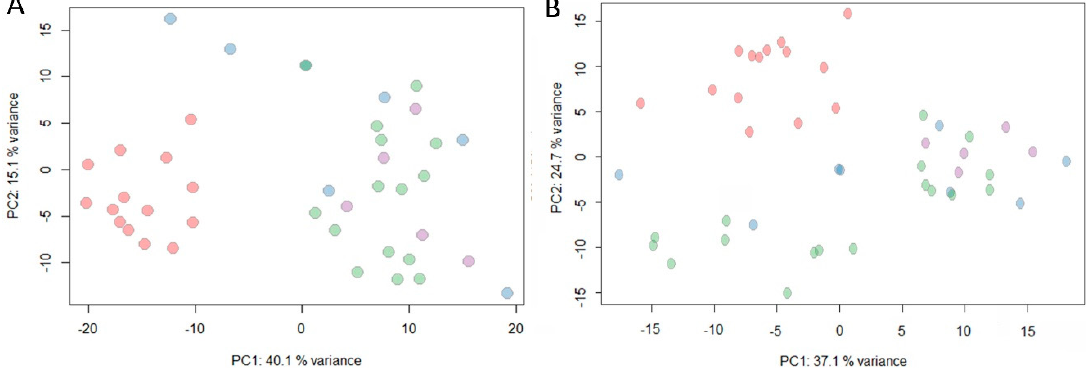
Figure 5. PCA based on ( A ) GC-MS and ( B ) LC-MS. Red, group A; blue, group B; green, group C; purple, group D.